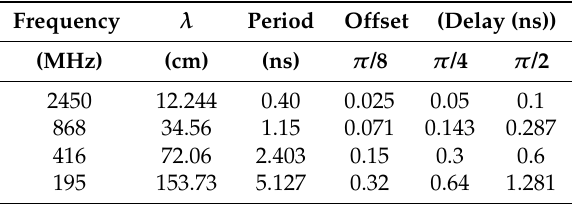
Table 1. Detail of the λ and period for some IEEE 802.15.4 (n) frequencies and the specific delay required for offsets( δ ) of π /8, π /4 and π